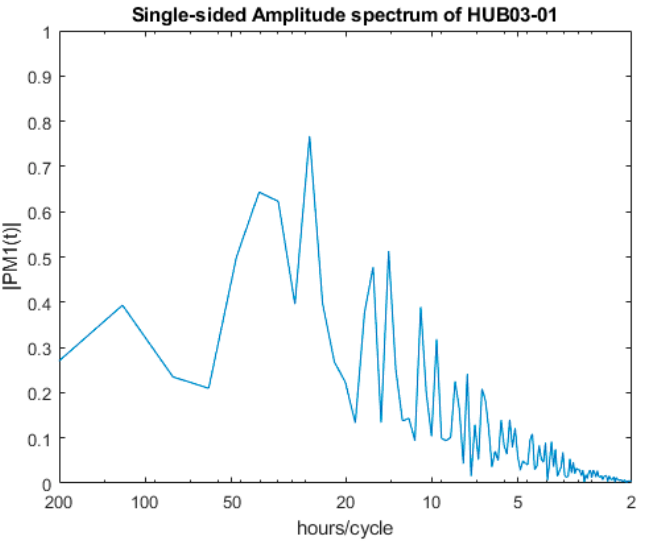
Figure 14. Fourier transform analysis of valve openings of mollusc HUB03-01 in the first study group, from 30 March 2018 to 12 April 2018 (x-axis in semi-logarithmic scale).